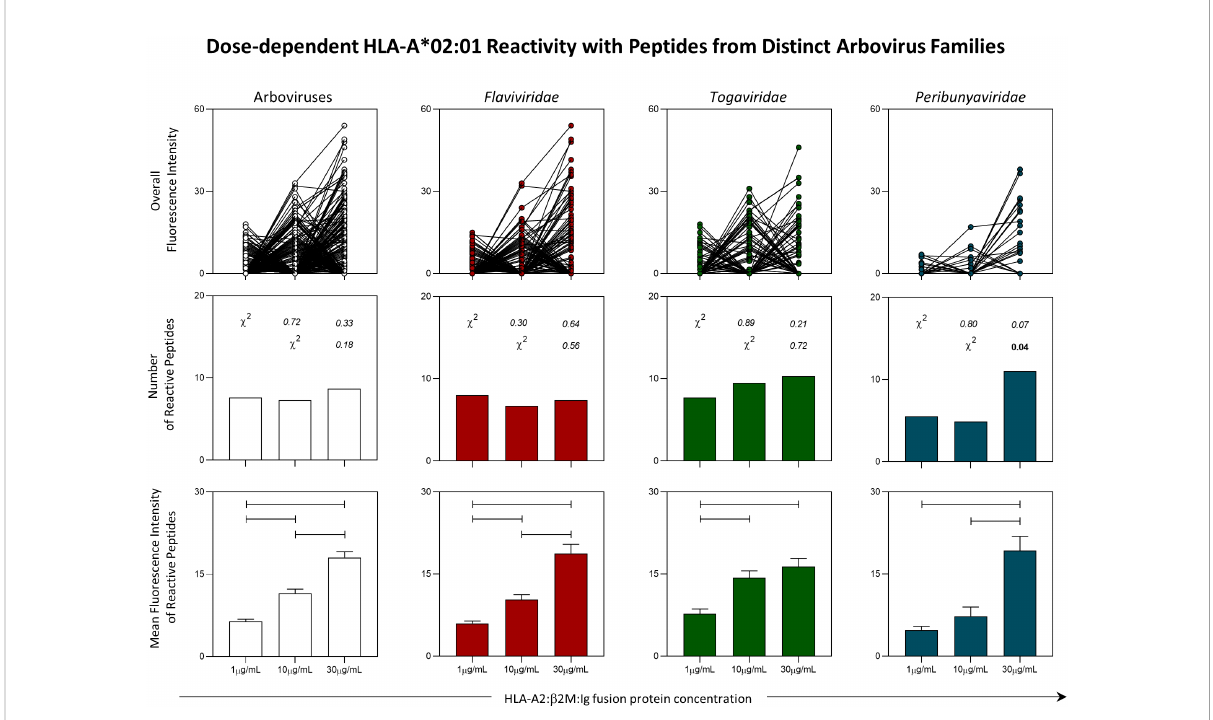
FIGURE 4 Panoramic Evaluation of HLA-A*02:01 Reactivity for Peptides Derived from Arbovirus. Peptide microarray was performed with an HLA-A*02:01 dimeric protein in three concentrations (1µg/mL, 10µg/mL and 30µg/mL). Overall fl uorescence of peptide-HLA-A*02:01 reactivity (top panels), absolute number of HLA-*02:01-reactive peptides (middle panels) and mean of fl uorescence intensity of HLA-*02:01-reactive peptides (lower panels) were evaluated. Chi-square test ( c 2) was used to compare the number of HLA-A*02:01-reactive. Obtained p values are indicated above each bar. Comparisons regarding the mean of fl uorescence intensity of HLA*02:01-reactive peptides were performed using the Kruskal-Wallis. Statistical signi fi cances were considered for p < 0.05 and are indicated by connecting